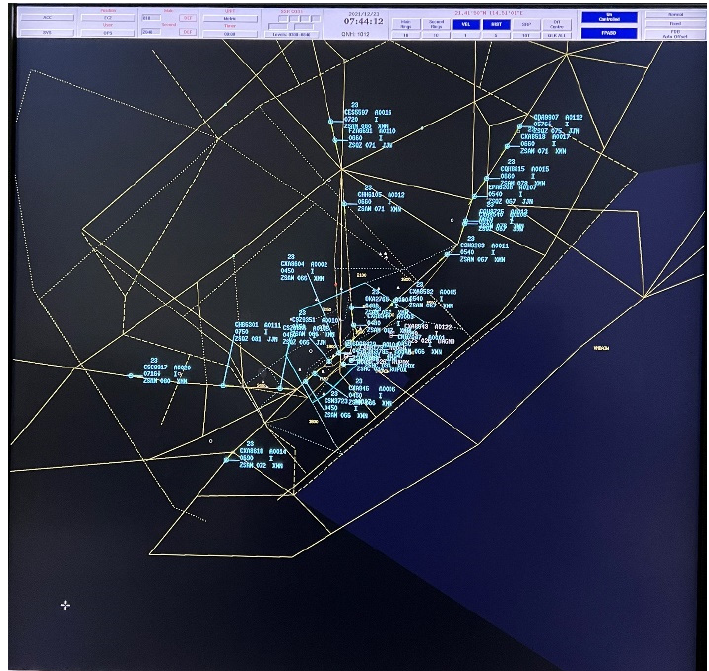
Figure 11. Radar control chart of Xiamen Gaoqi Airport.